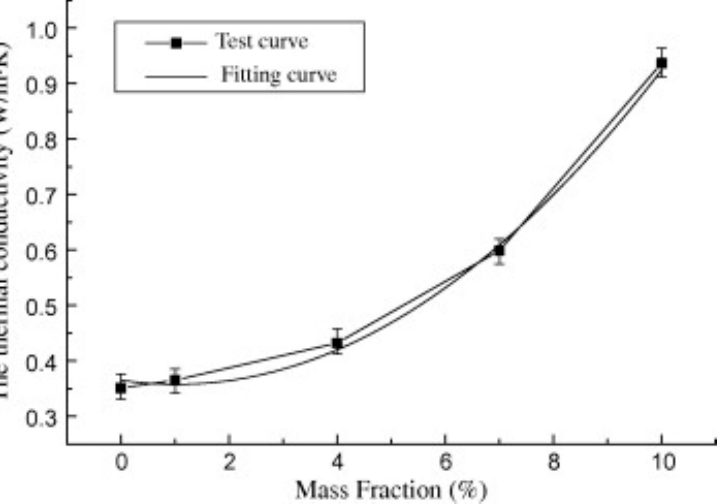
Figure 9. Increase in thermal conductivity of paraffin with increase in graphite nanoparticles. (Reprinted with permission from ref. [22]. Copyright 2013 Applied Energy).